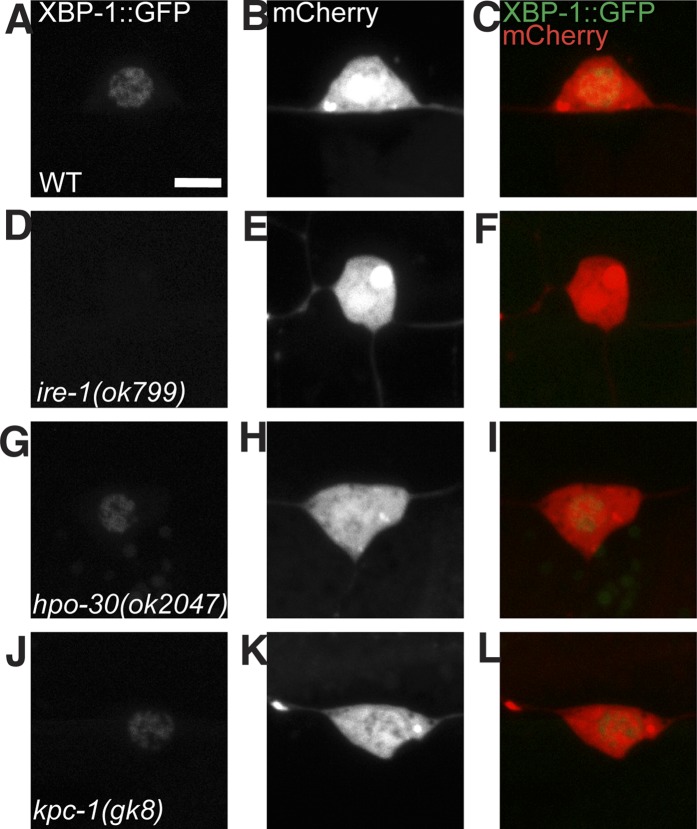
The UPR activity in PVD does not depend on other known proteins that are processed in the ER and are required for PVD dendrite morphogenesis.The PVD UPR activity in WT (A to C), ire-1 (D to F), hpo-30 (G to I) and kpc-1 mutants (J to L). UPR activity is indicated by XBP-1::GFP brightness while the intensity of mCherry is used to normalize for transgene expression level. Scale bar, 5 μm.